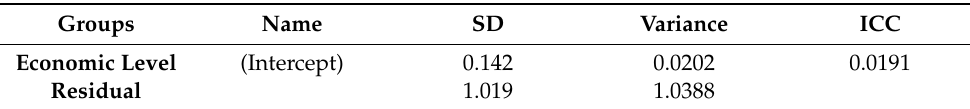
Table 5. Random components of the predictors of willingness to receive COVID-19 vaccines, February 2021 ( n = 6639).